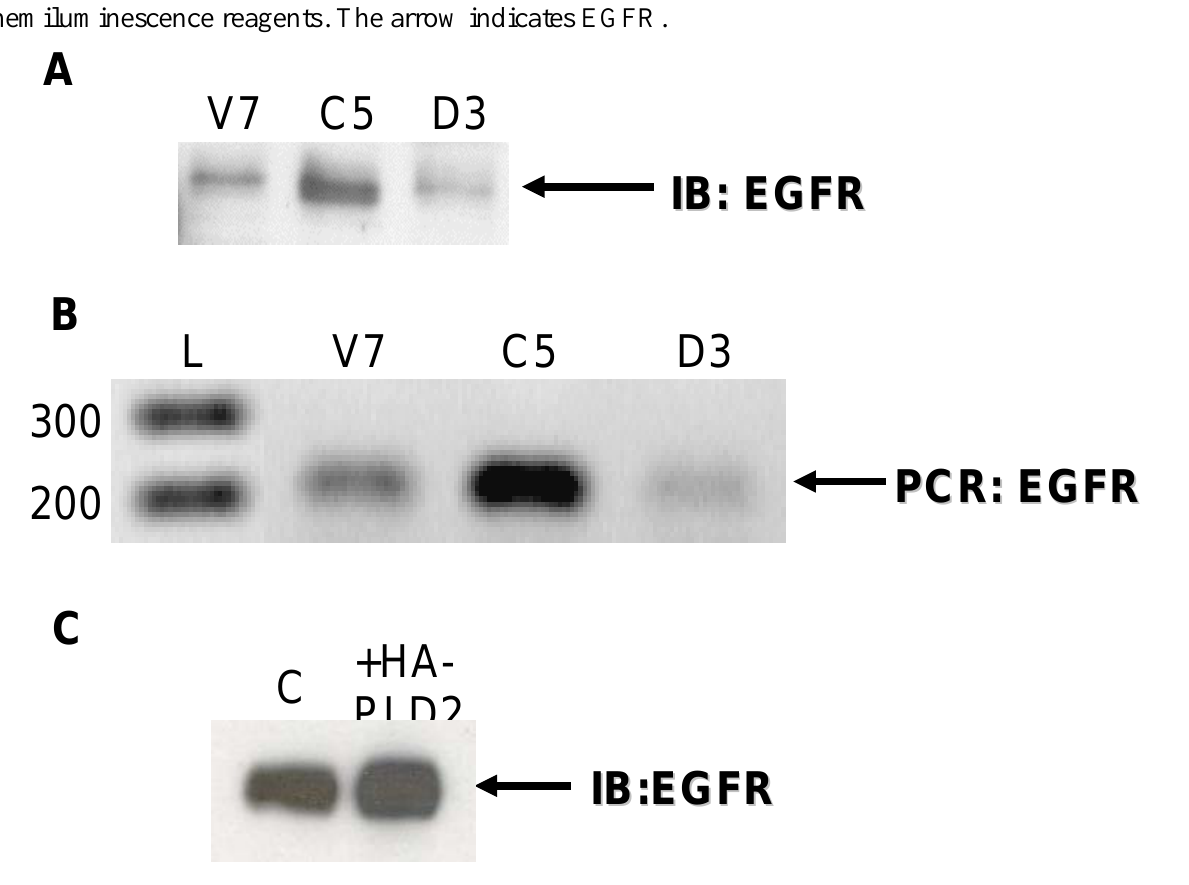
Figure 1. Expression of EGFR in EL4 and OVCAR3 cells. (a) Protein from EL4 whole-cell lysates (100 µg) was resolved by SDS-PAGE and transferred to a PVDF membrane. An antibody recognizing EGFR was used to detect EGFR expression. The blot was developed using chemiluminescence reagents. The arrow indicates EGFR. (b) Equal amounts of total RNA from each EL4 cell line were used to synthesize cDNA primed by anti-sense EGFR primer. PCR was performed using cDNA and murine EGFR primers in the linear range of amplification. PCR products were separated on an agarose gel, stained with ethidium bromide, and imaged. The arrow indicates PCR-amplified product from murine EGFR primers. L = DNA ladder (bp). (c) OVCAR3 cells were transiently transfected with or without HA-tagged PLD2 for 48 hours. Following transfection, cells were grown in serum-containing medium for 48 hours. Cells were then harvested and whole-cell extracts prepared. Extracts, equalized for protein, were resolved by SDS-PAGE and transferred to a PVDF membrane. An